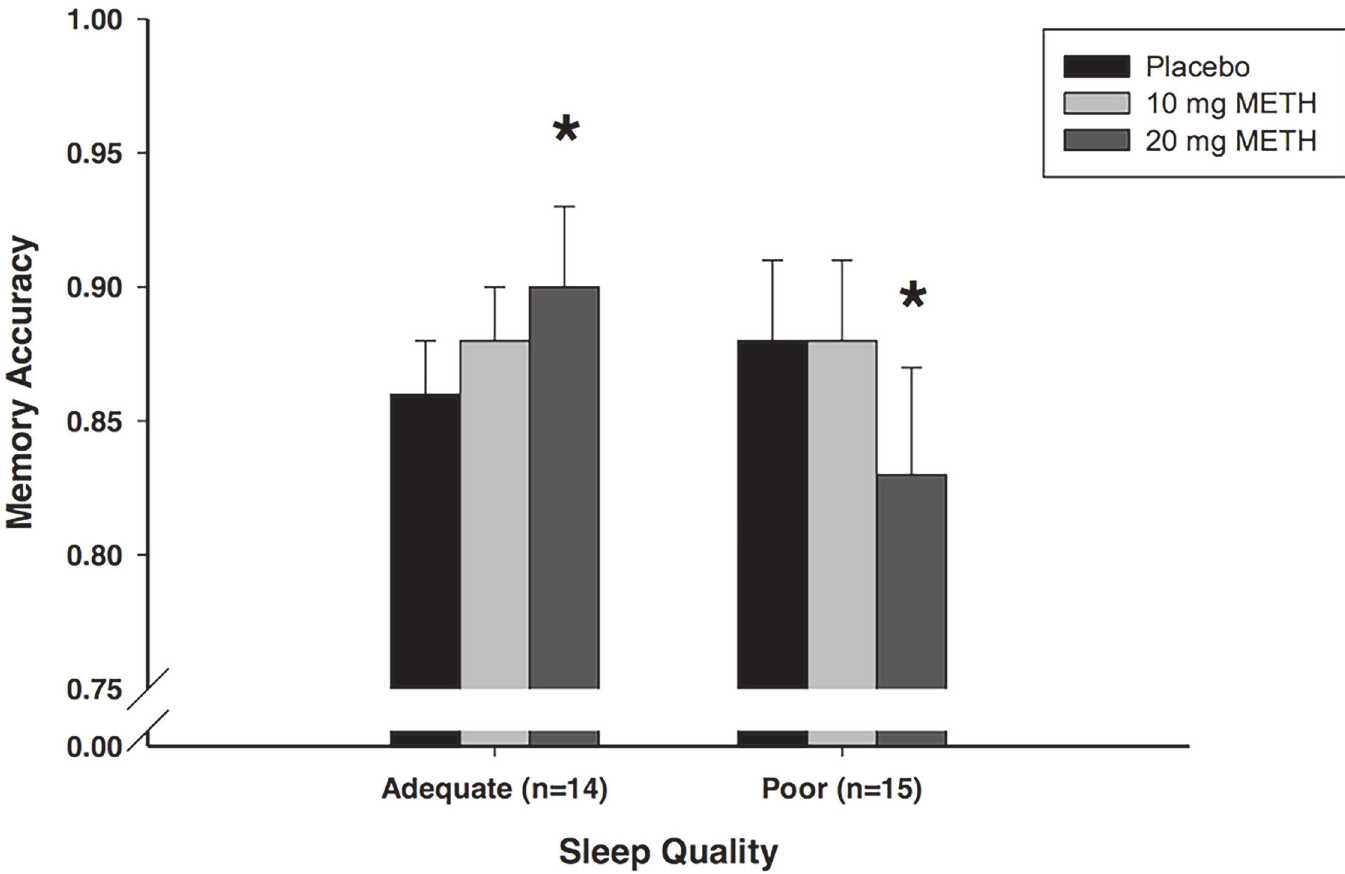
Fig 1. Meth effects on recognition. Effects of METH on mean (+/- SEM) recognition accuracy as a function of self-reported sleep quality in the encoding group. Adequate sleep group consists of participants who reported sleeping at least six hours the night after receiving the 20 mg dose ( n = 14); poor sleep group consists of participants who reported sleeping less than six hours the night after receiving the 20 mg dose ( n = 15). 1 = perfect discrimination; 0 = no discrimination (chance responding). * p < .05 compared to placebo